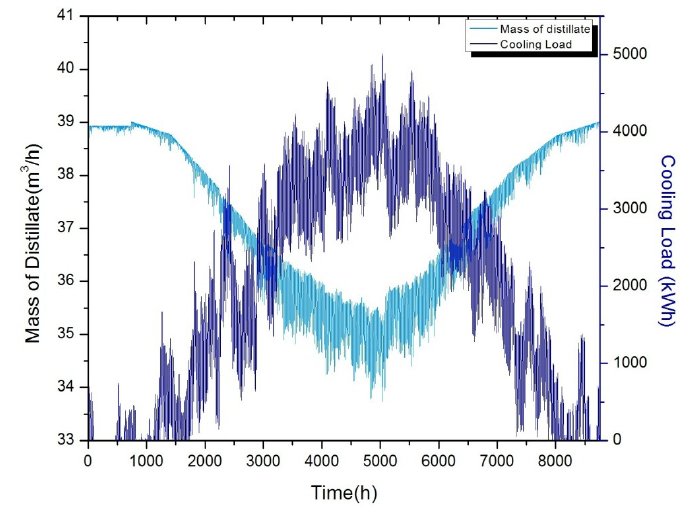
Figure 13. Effect of cooling load on distillate production.